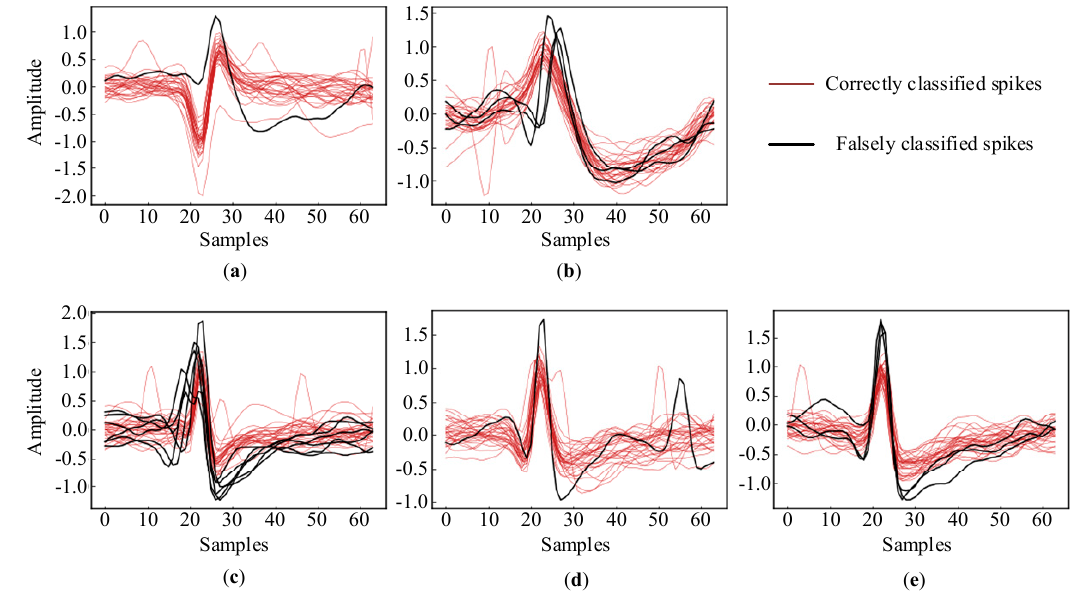
Figure7. Falselyclassifiedspikesandrandomlyselectedcorrectlyclassifiedspikes: ( a , b )C_Easy1_noise015; Figure 7. Falsely classified spikes and randomly selected correctly classified spikes: ( a , b ) ( c – e ) C_Di ffi cult1_noise015. C_Easy1_noise015; ( c – e ) C_Difficult1_noise015.